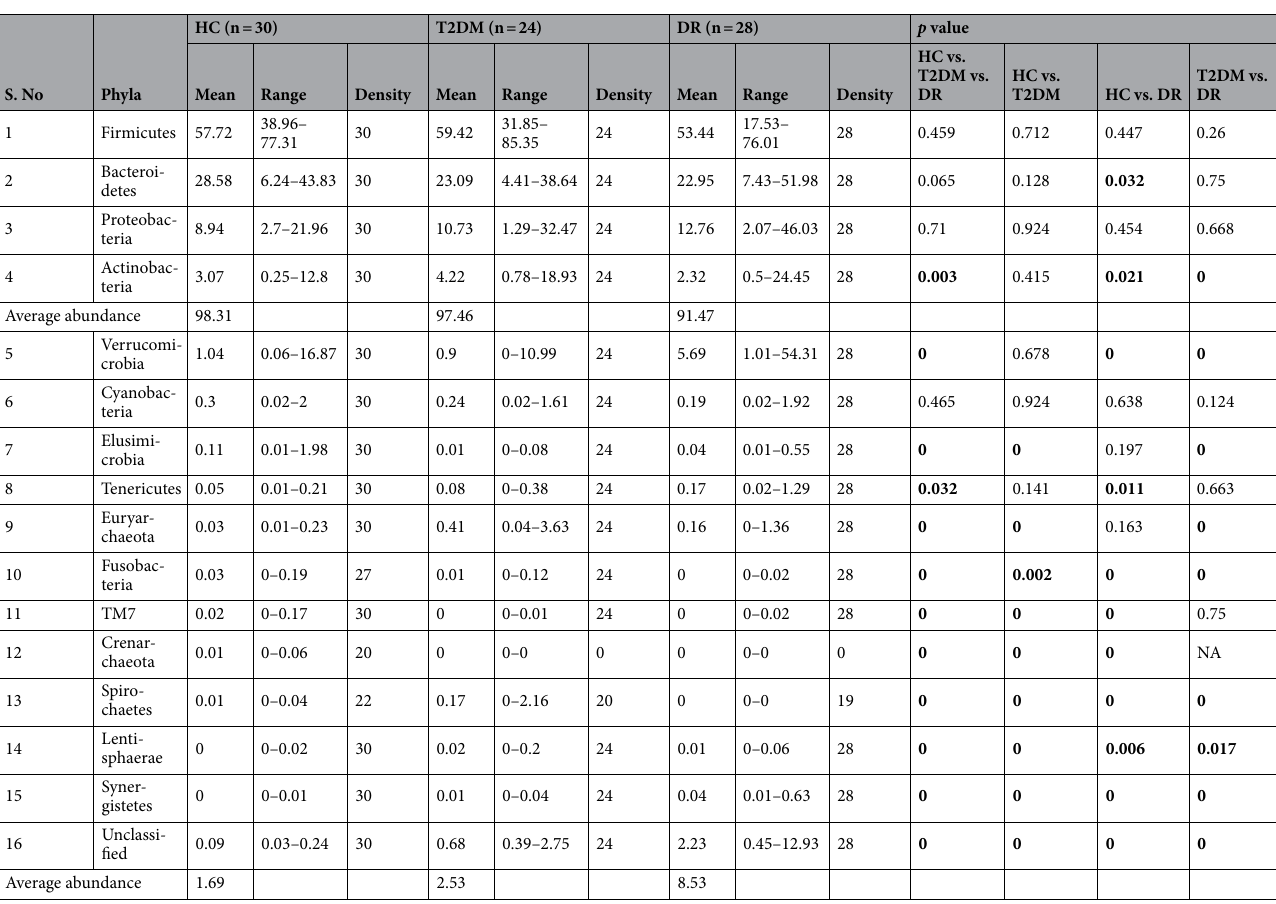
Table 2. Mean abundance (%) of bacterial phyla in the gut microbiomes of healthy controls (HC, n = 30), type 2 diabetes mellitus (T2DM, n = 24) and diabetic retinopathy (DR, n = 28)